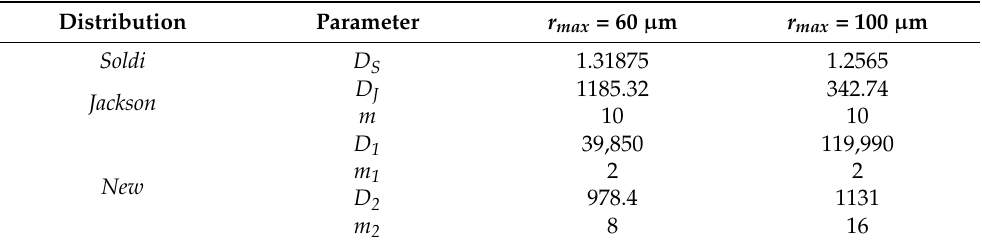
Table 2. Values required for each parameter of Soldi , Jackson and New CSD functions to obtain porosity of 18.75% for constant radius BOCT model when dr c = 0.1 µ m. Number of significant figures varies due to the requirement to match porosity